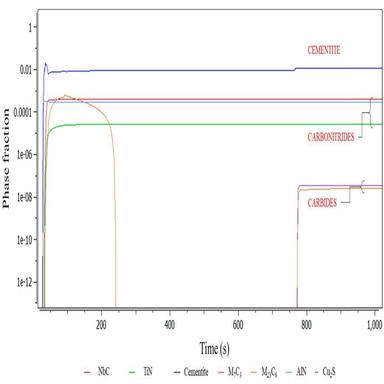
Prediction of phase fraction evolution in X100Q PM under bainitic transformation using precipitation kinetics simulations in MatCalc.